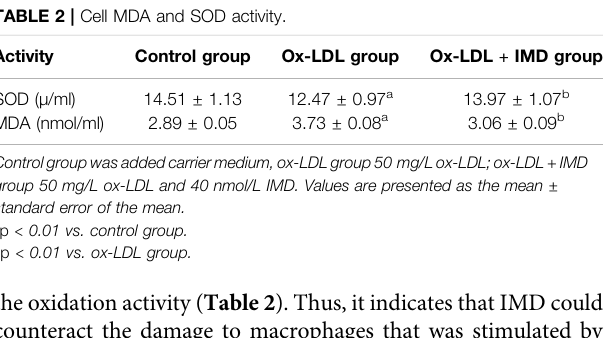
Frontiers in Pharmacology |